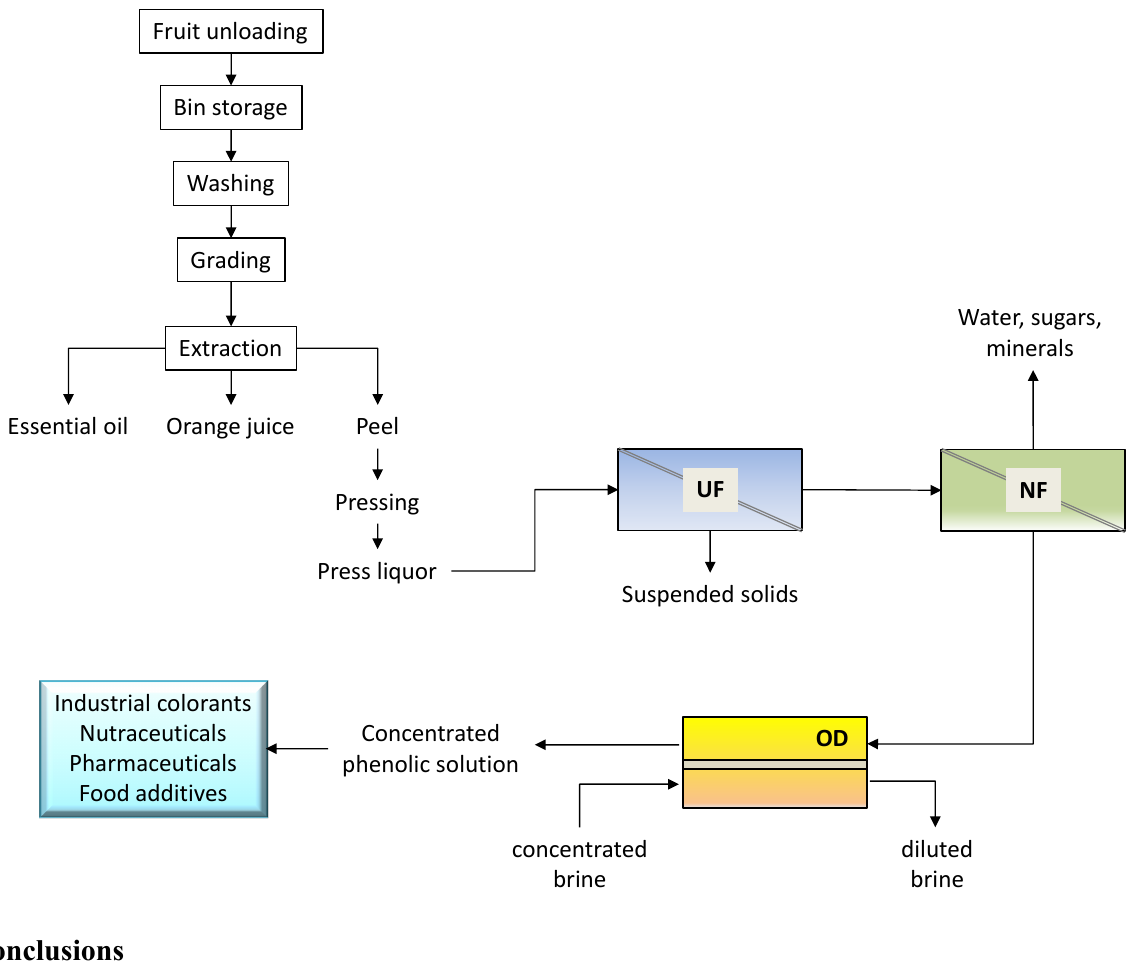
Figure 7. Schematic of the integrated membrane process proposed for the recovery of flavonoids from orange press